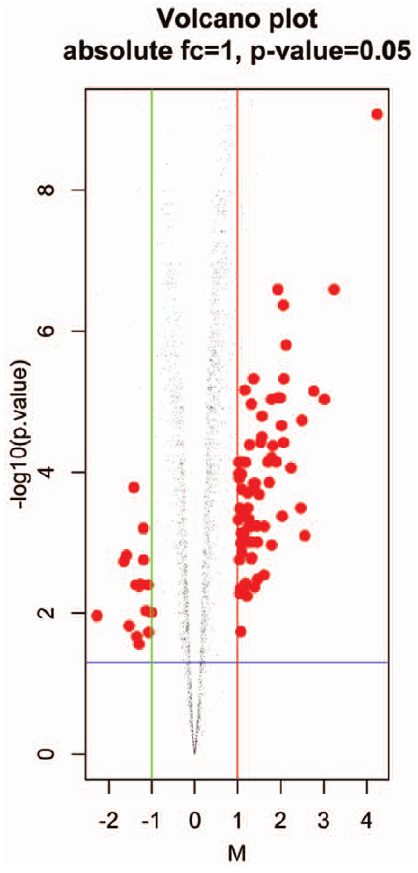
Figure 3. Volcano plot. This representation of data resulting from microarray analysis compares the size of the fold change with the statistical significance level. x-axis: log 2 of FC (fold change of differential gene expression between the ALS patients and controls); y-axis: corresponding p-value resulting from t-test used to measure the significance of the difference between samples in tially expressed gene list (table 2) and the discriminant gene list (table 3) were 59 and are reported in bold in table 3.